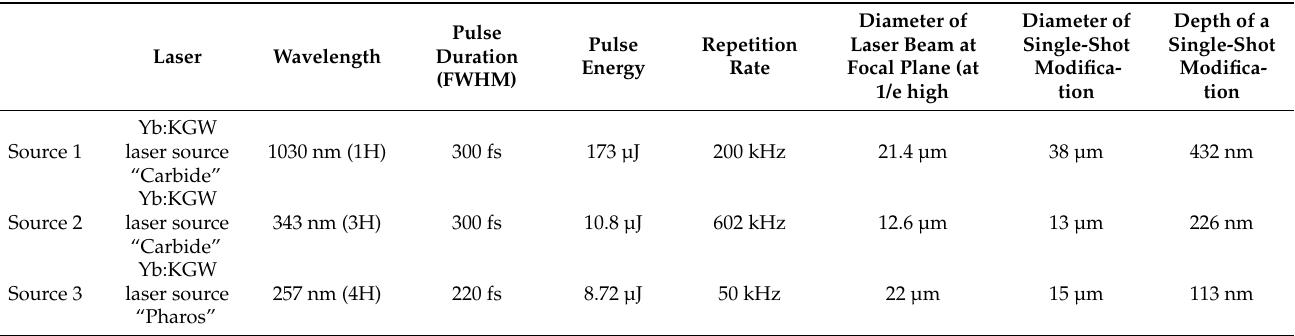
Table 1. Parameters of different laser sources used in the study and the properties of single- shot modifications.